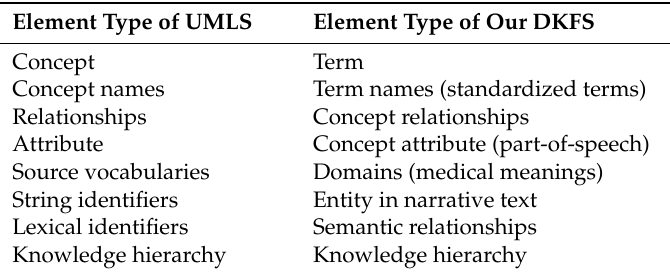
Table 1. Element-mapping relationships between the UMLS Metathesaurus and our Domain-Knowledge Support Framework (DKSF).